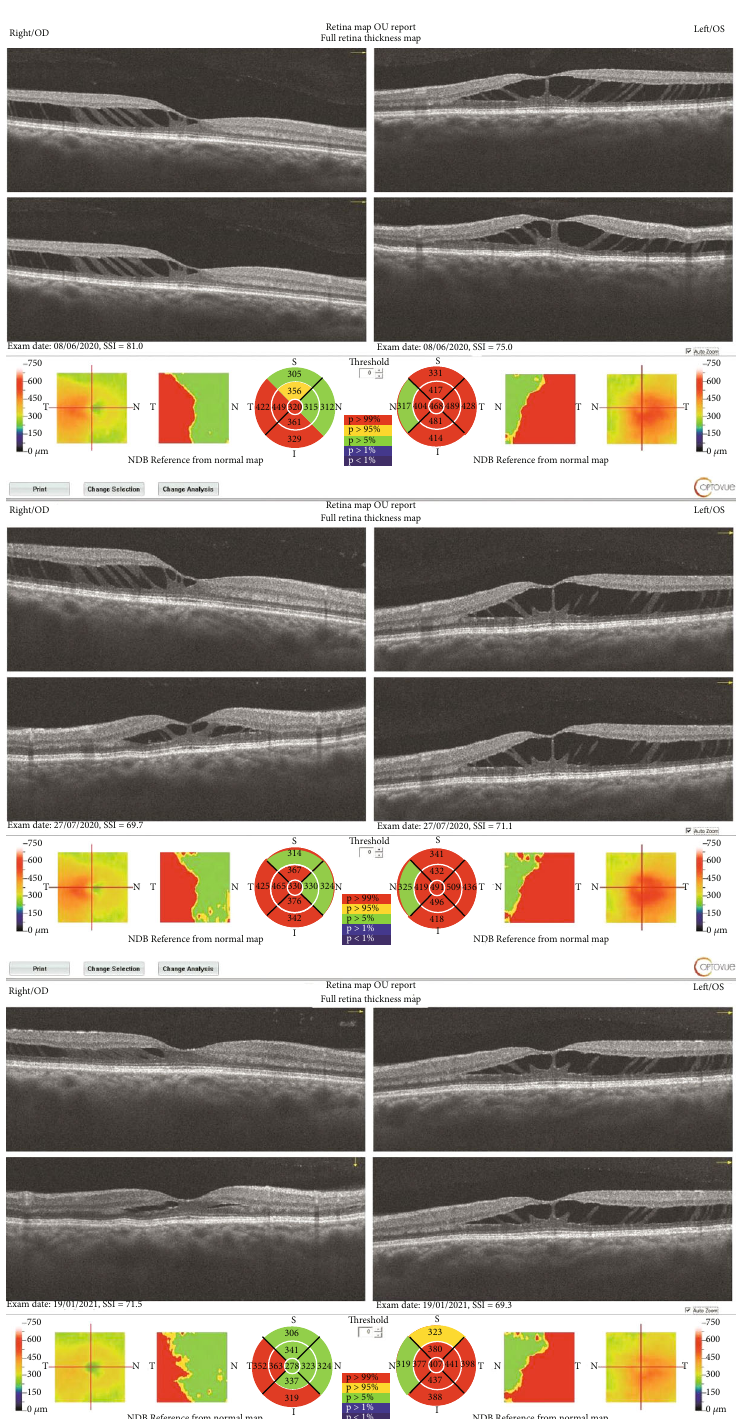
Figure 1: Bilateral OCT-imaging preoperative, 1 day postoperative and 6 months